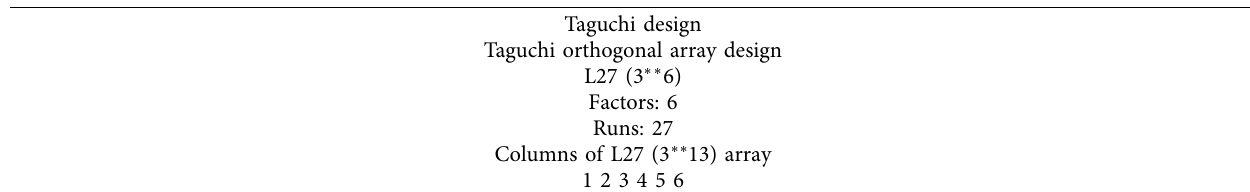
Table 15: Taguchi analysis for optimal water